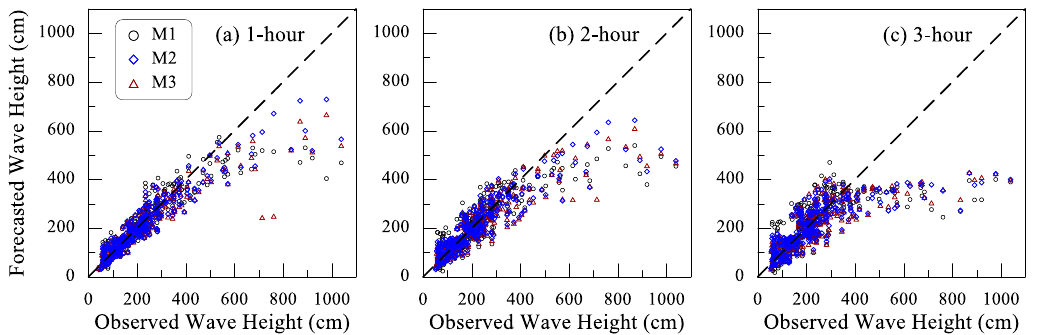
Figure 4. Forecasting results with lead time of ( a ) 1, ( b ) 2, and ( c ) 3 h for Longdong.